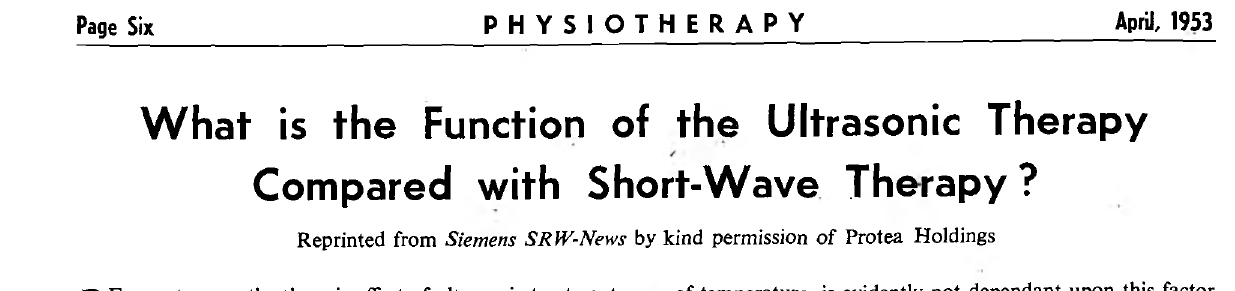
Fig. 1 - Diagrammatic representation of heat distribution in a homogeneous body